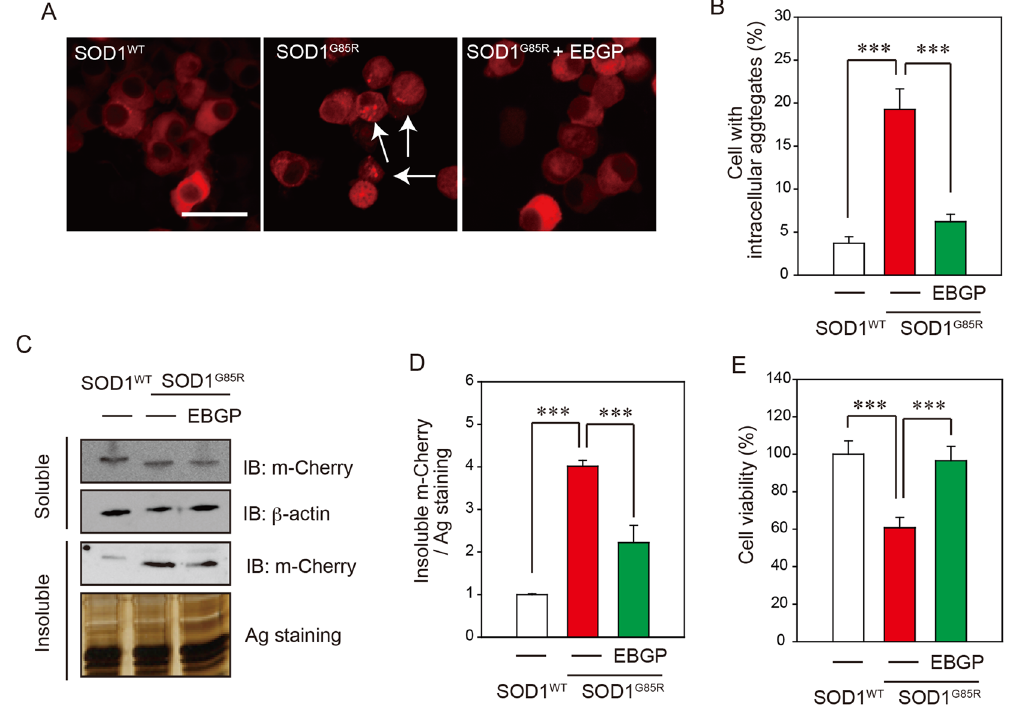
Figure 2. EBGP protected SOD1 G85R -induced neurotoxicity via the reduction of the aggregates of SOD1 G85R . ( A ) Representative fluorescent microscopy images of N2a cells expressing mCherry-SOD1 G85R incubated for 24 h with 20 ng/mL EBGP. The arrowheads indicate the intracellular SOD1 aggregates. ( B ) Quantified data of intracellular SOD1 aggregates are expressed as mean ± S.E.M from three independent experiments. In each experiment, at least 200 cells were counted. ( C ) Reduction of Triton-insoluble mutant SOD1 G85R by EBGP. After treatment of 20 ng/mL EBGP, N2a cells expressing SOD1 G85R were lysed with 1% TritonX-100. Triton-insoluble fraction was resuspended with 2% SDS and analyzed with immunoblotting. ( D ) The density of Triton-insoluble mutant SOD1 G85R is given as mean ± S.E.M from three independent experiment, based on the density of Triton- insoluble mutant SOD1 WT . ( E ) N2a cells expressing mCherry-SOD1 G85R were treated with 20 ng/mL EBGP. The cell viability was measured by MTT assay. *** p < 0.001. Scale bar: 50 µ